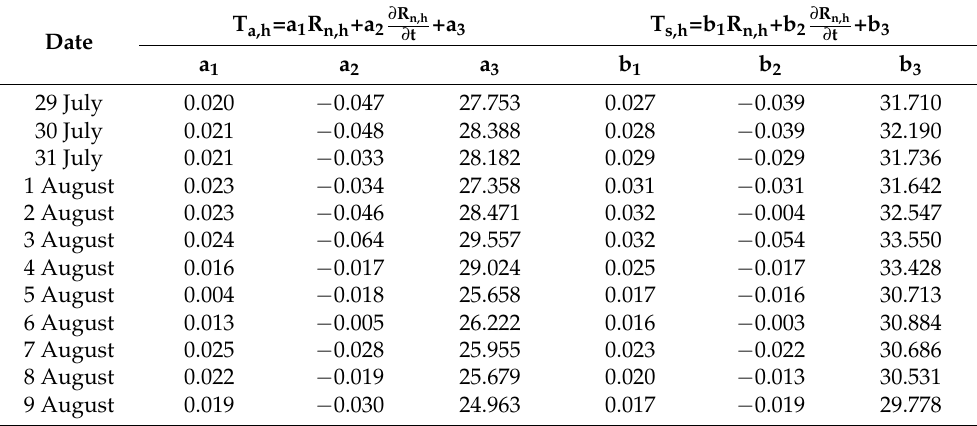
Table 1. Regressed coefficients characterizing temperature-radiation lag effect of the